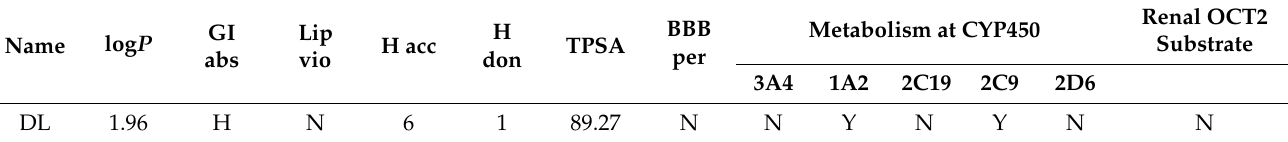
Table 10. DL physiochemical properties